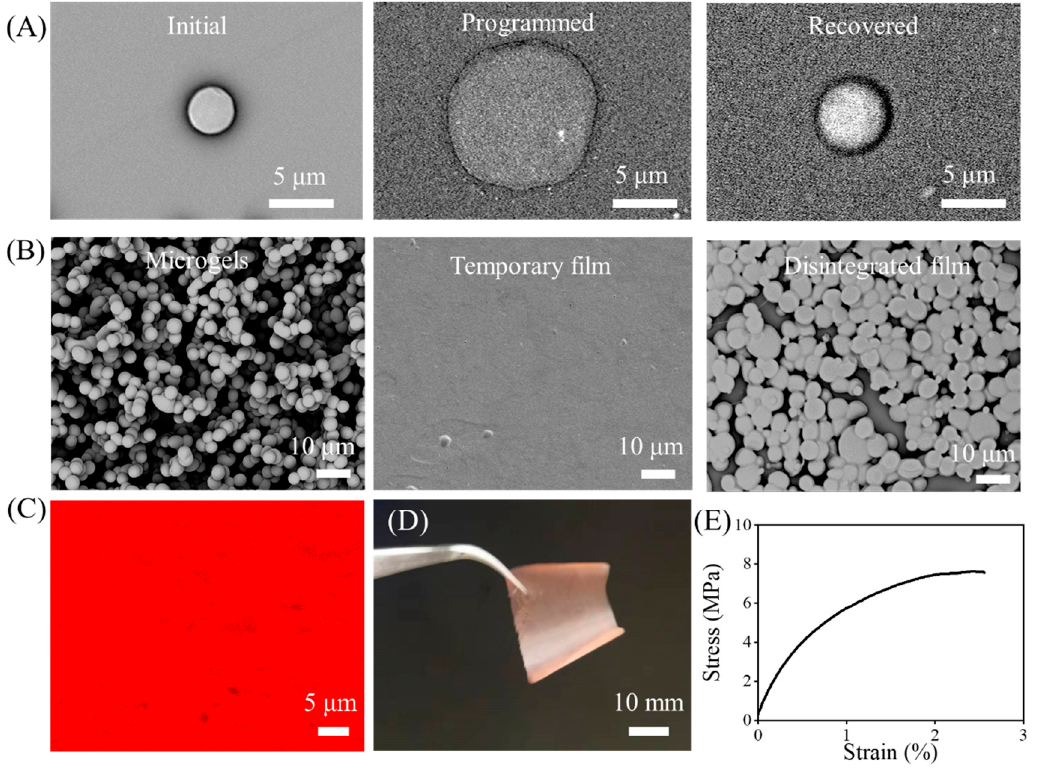
Figure 2. ( A ) SEM images of the initial, programmed, and recovered single microgels. ( B ) SEM images of the microgels with the high deposition density, temporary film, and the disintegrated film. ( C ) CLSM image showing the DOX distribution. ( D ) Digital photo of the temporary film. ( E ) Tensile test of the temporary film.